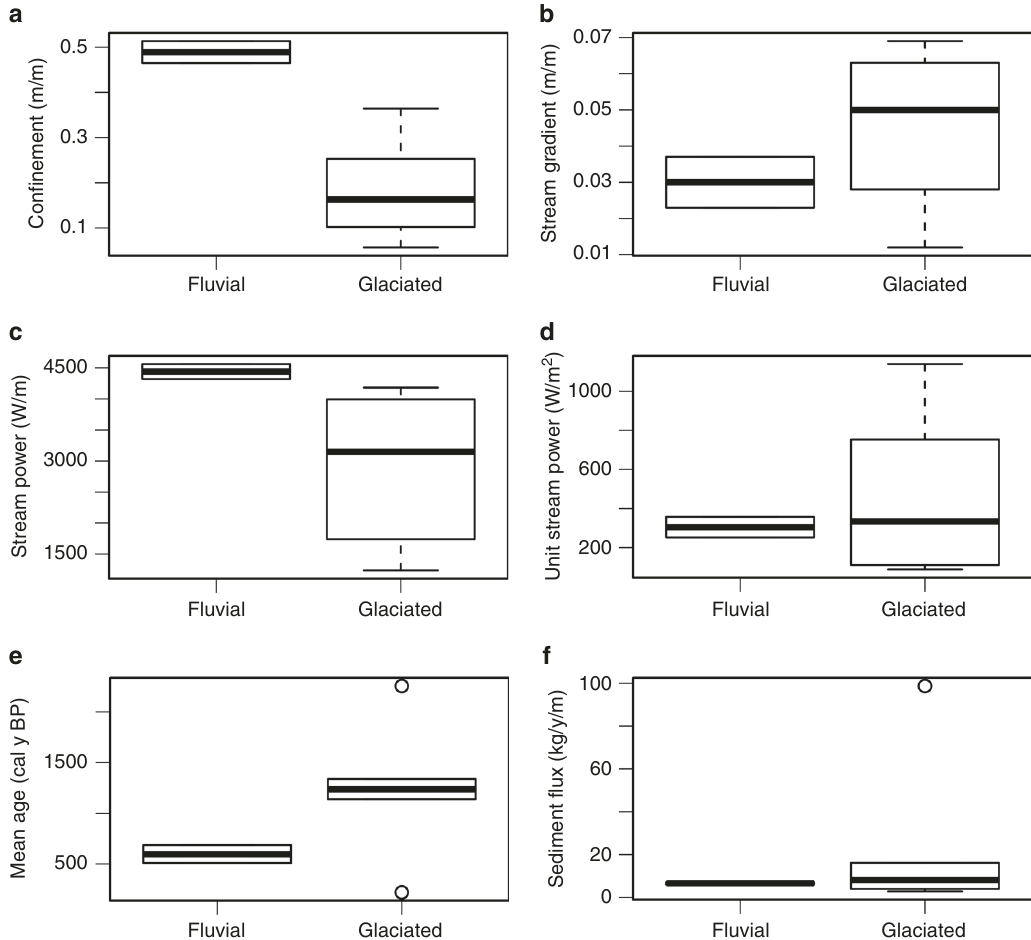
Fig. 4 Boxplots of potential predictor variables. P values from Welch ’ s t test for signi fi cant differences in means between glaciated ( n = 6) and non- glaciated ( fl uvial; n = 2) study sites are p = 0.001 for con fi nement ( a ), p = 0.251 for stream gradient ( b ), p = 0.031 for stream power ( c ), p = 0.412 for unit stream power ( d ), p = 0.063 for mean age ( e ), and p = 0.331 for sediment fl ux ( f ). Thick lines represent the median (50th percentile), upper and lower edges of the boxes represent the 25th and 75th percentile. Whiskers extend to the minimum and maximum values within 1.5 times the interquartile range and open circles are outliers exceeding that range. Source data is listed in Table